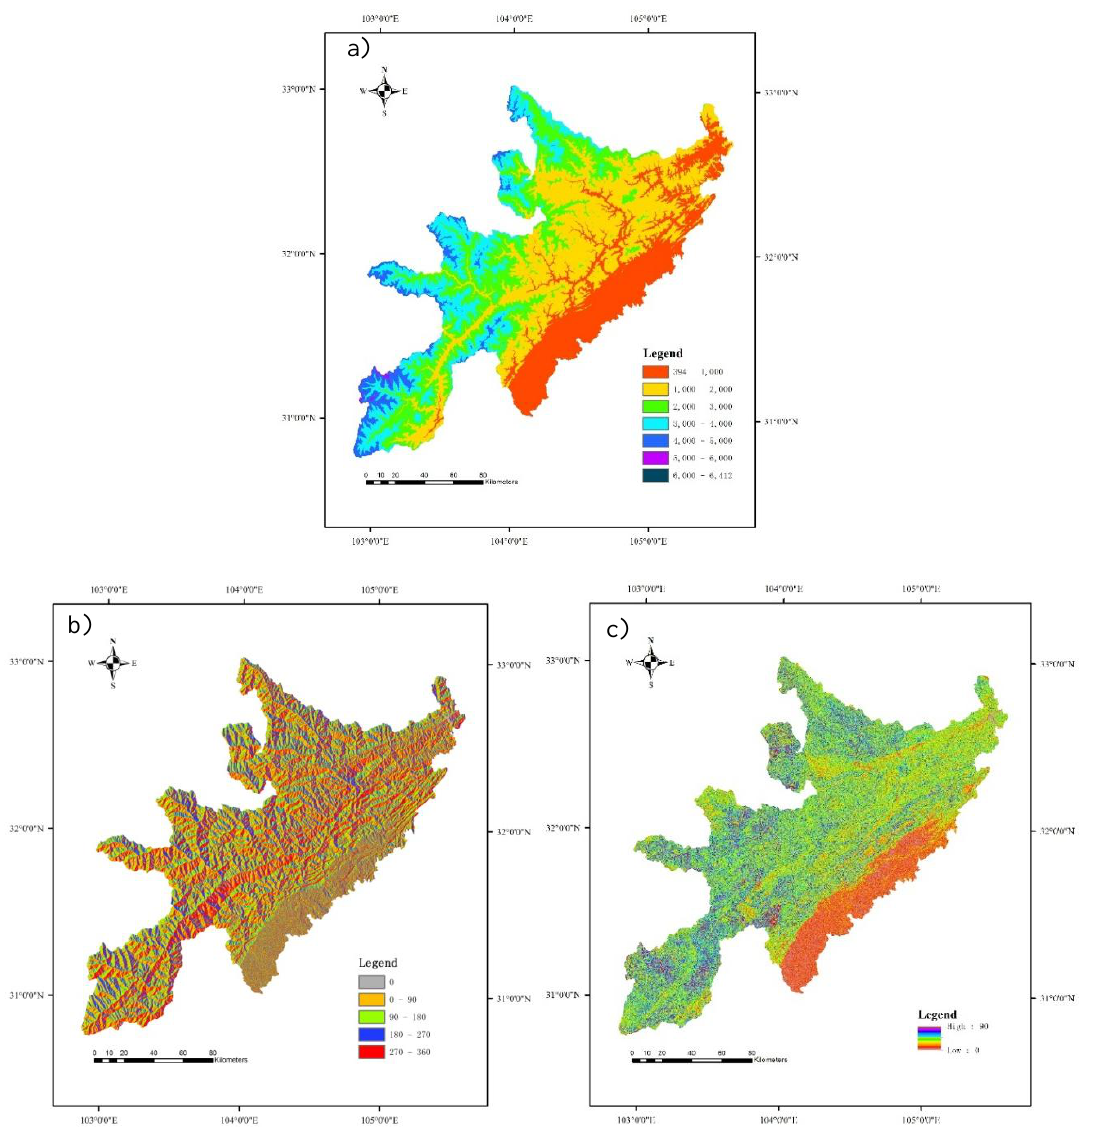
Figure 2. The digital elevation model (DEM) of the 25 m × 25 m cell size ( a ), aspect ( b ), and slope ( c ) in nine worst-hit cities and counties.